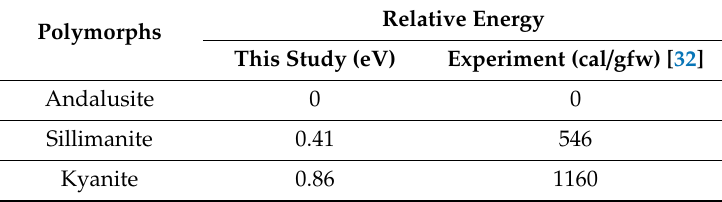
Table 4. Comparison between experimental and calculated relative energies of polymorphs of Al 2 SiO 5 . Relative Energy Polymorphs This Study